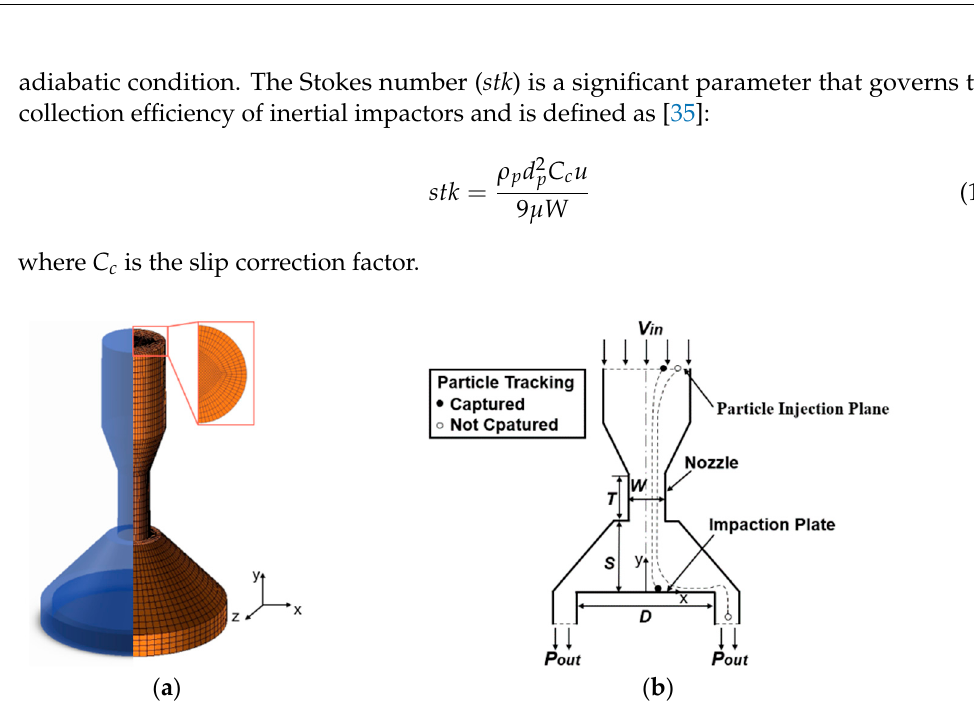
Figure 1. Schematic of the model and the grid model. ( a ) three-dimensional view. ( b ) cross-section view.